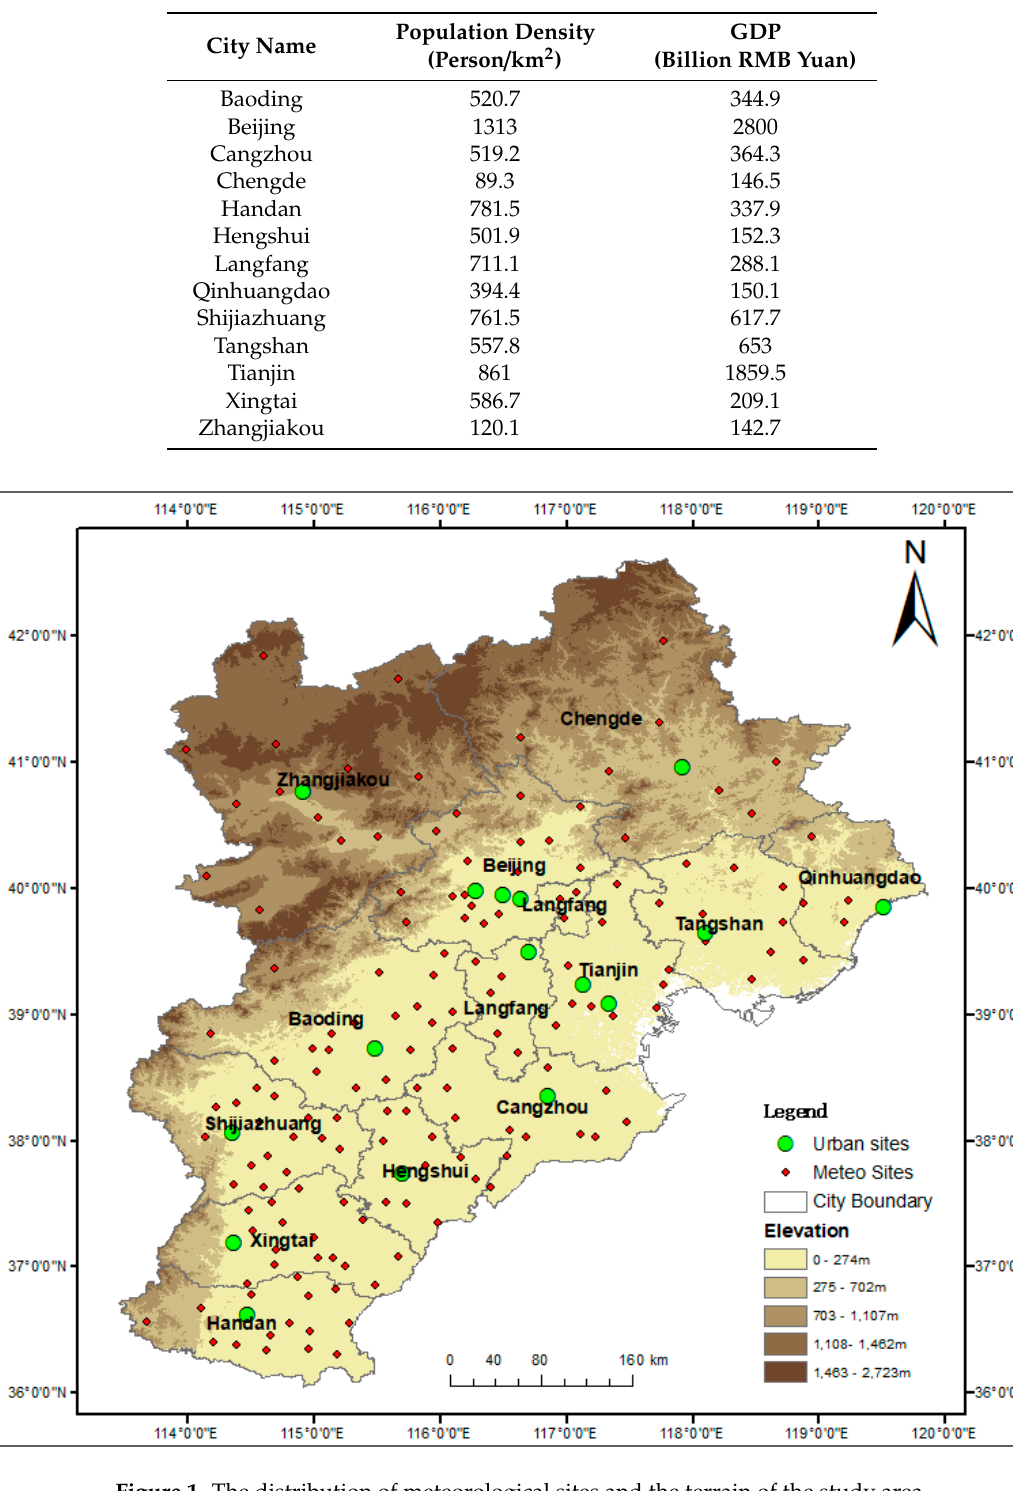
Table 1. Population density and gross domestic product (GDP) information for Beijing–Tianjing–Hebei (BTH) cities in 2015 (Data came from the statistical yearbook of Hebei province, Beijing city and Tianjin city, for example: http: // tjj.beijing.gov.cn / English).